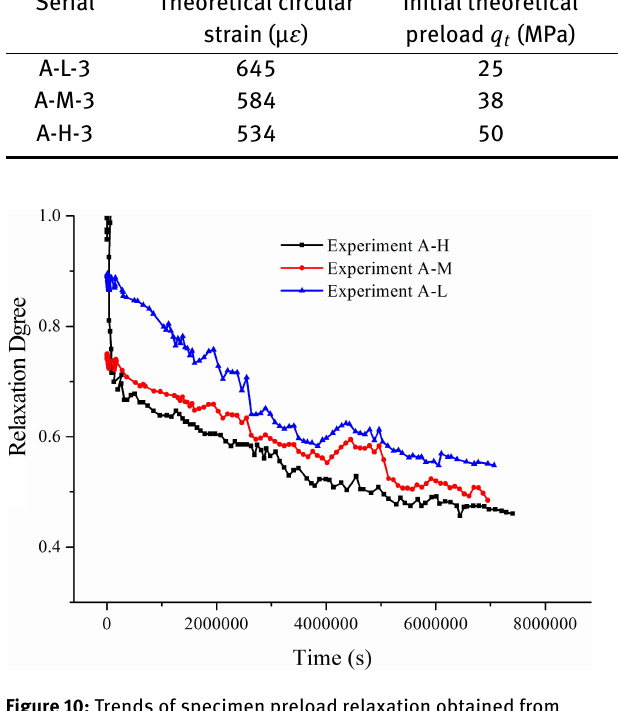
Figure 10: Trends of specimen preload relaxation obtained from